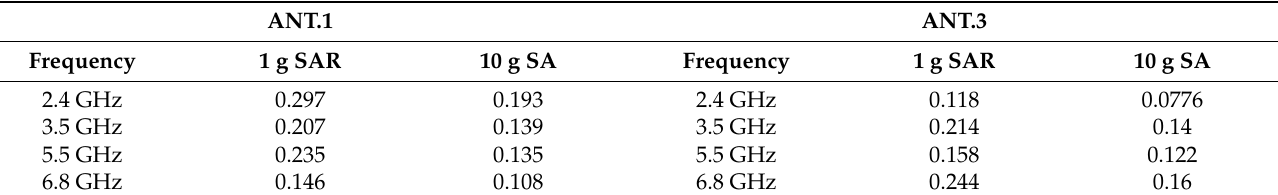
Figure 37. 10 g SAR simulation results of Ant. 1 at 2.4 GHz, 3.5 GHz, 5.5 GHz, and 6.8 GHz. Table 2. Simulated 1 g SAR and 10 g SAR for Ant. 1 and Ant. 3.